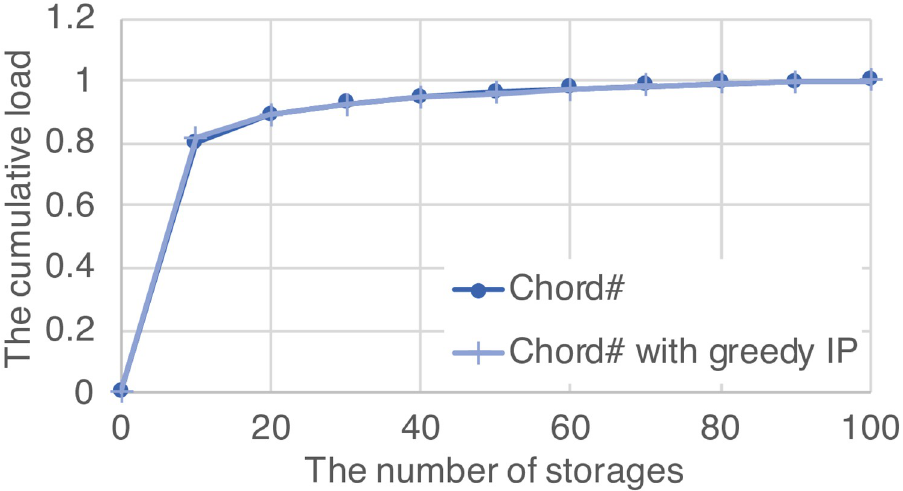
Fig 8. The effect of the proposed method on load